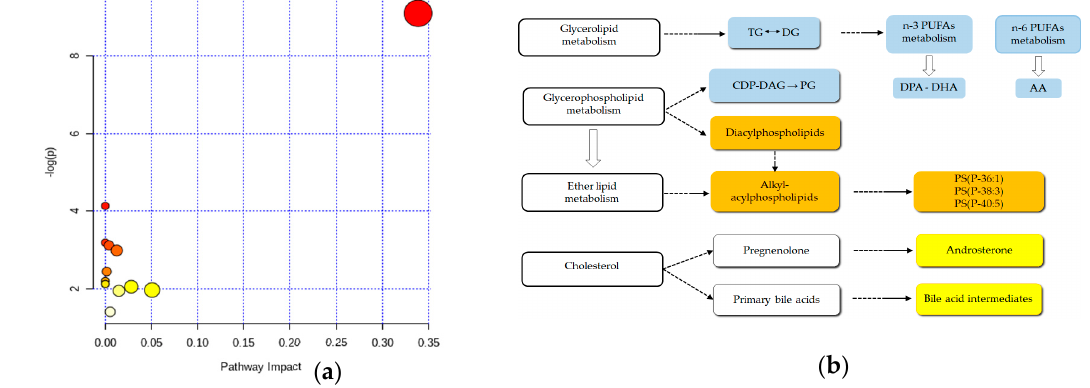
Figure 4. Metabolic pathways based on the identified potential biomarkers. ( a ) Pathway analysis performed using MetaboAnalyst 4.0. (*false discovery rate, FDR < 0.05). ( b ) Diagram of pathways associated with the lipid biomarkers of colon cancer CC plasma samples. Colored boxes represent an increase (orange and yellow) or decrease (blue) of metabolites when compared to (CTR) subjects. Diacylglycerols (DG), Triacylglycerols (TG), Cytidine Diphosphate-DG (CDP-DG), PUFA: polyunsaturated fatty acids, DPA: docosapentaenoic acid and DHA: docosahexaenoic acid, ARA: arachidonic acid, PS: phosphatidylserine.